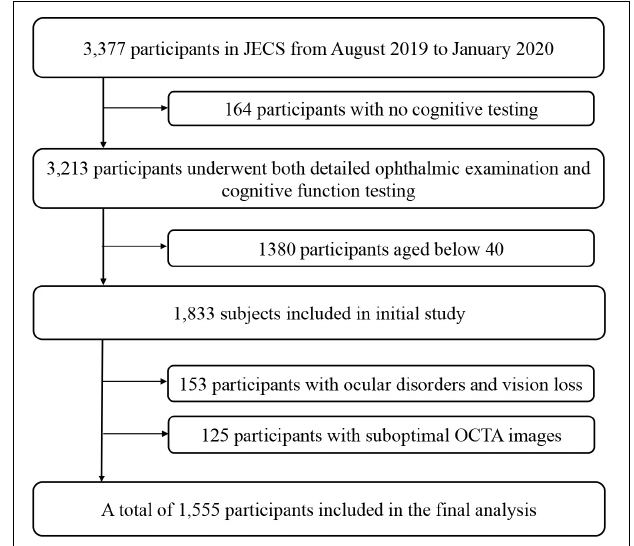
FIGURE 1 | Flow Chart of the Study Population. JECS, Jidong Eye Cohort Study; OCTA, optical coherence tomography angiography.